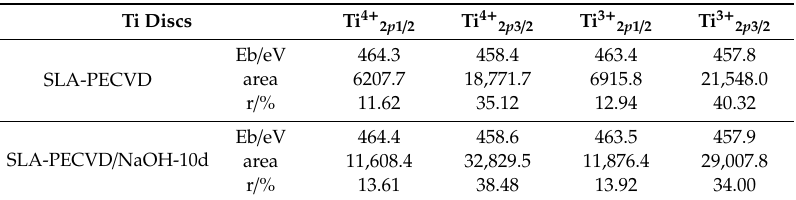
Binding energy, area, and proportion of the Ti2 p peaks for the SLA-PECVD and SLA-PECVD / NaOH-10d samples.